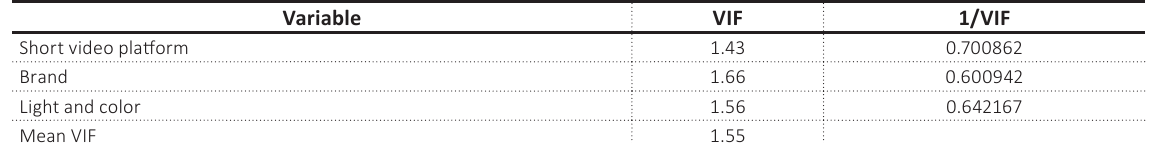
Table 3. VIF values